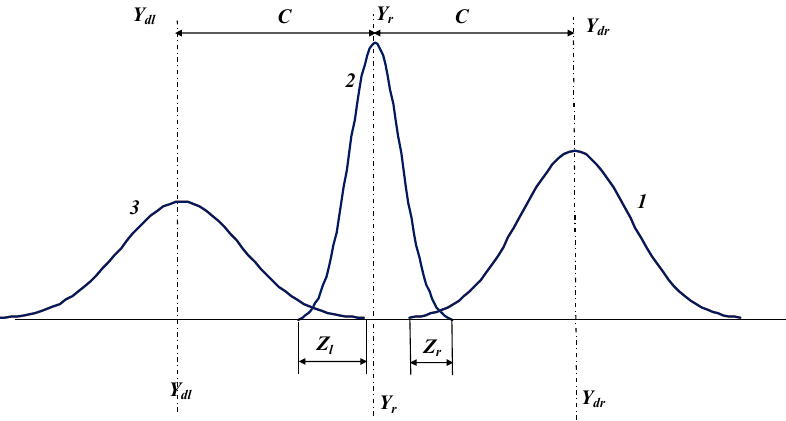
Figure 5. Probability density function of the transverse displacements from the set trajectory of movement of the right 1 and left 3 working implements located on both sides of the row and position deflections of the plants from the row axis 2 .